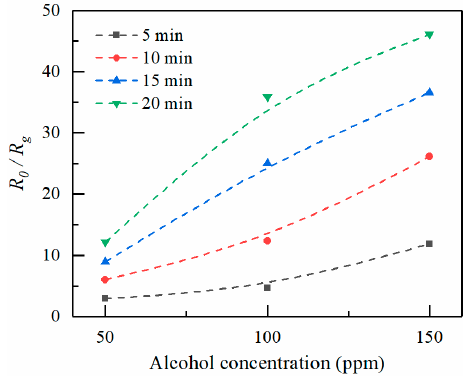
Figure 9. Sensing response of ZnO thin films formed at increasingly longer electrospray times and exposed to increasingly large alcohol concentrations.